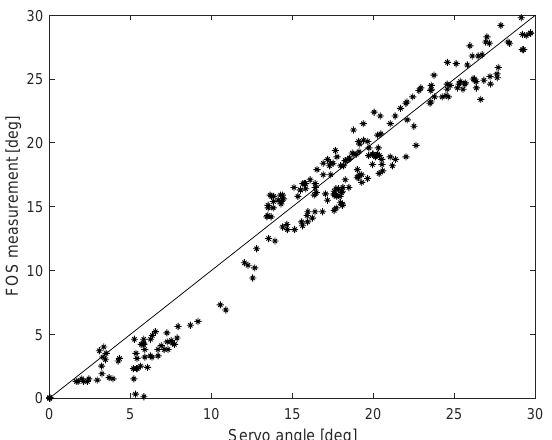
Figure 16. The mismatch in estimation between the servo command and the fiber optic sensor (FOS) measurement in